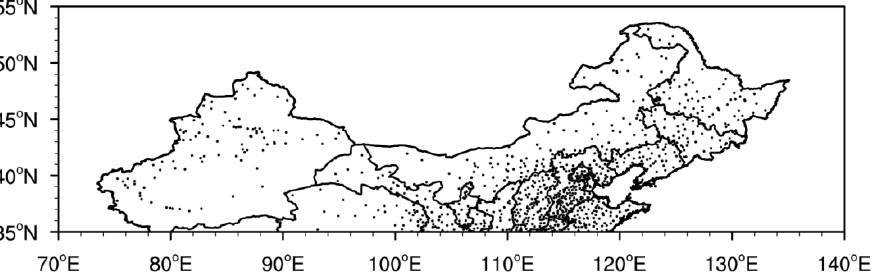
Figure 1. Distribution of 903 stations in northern China.